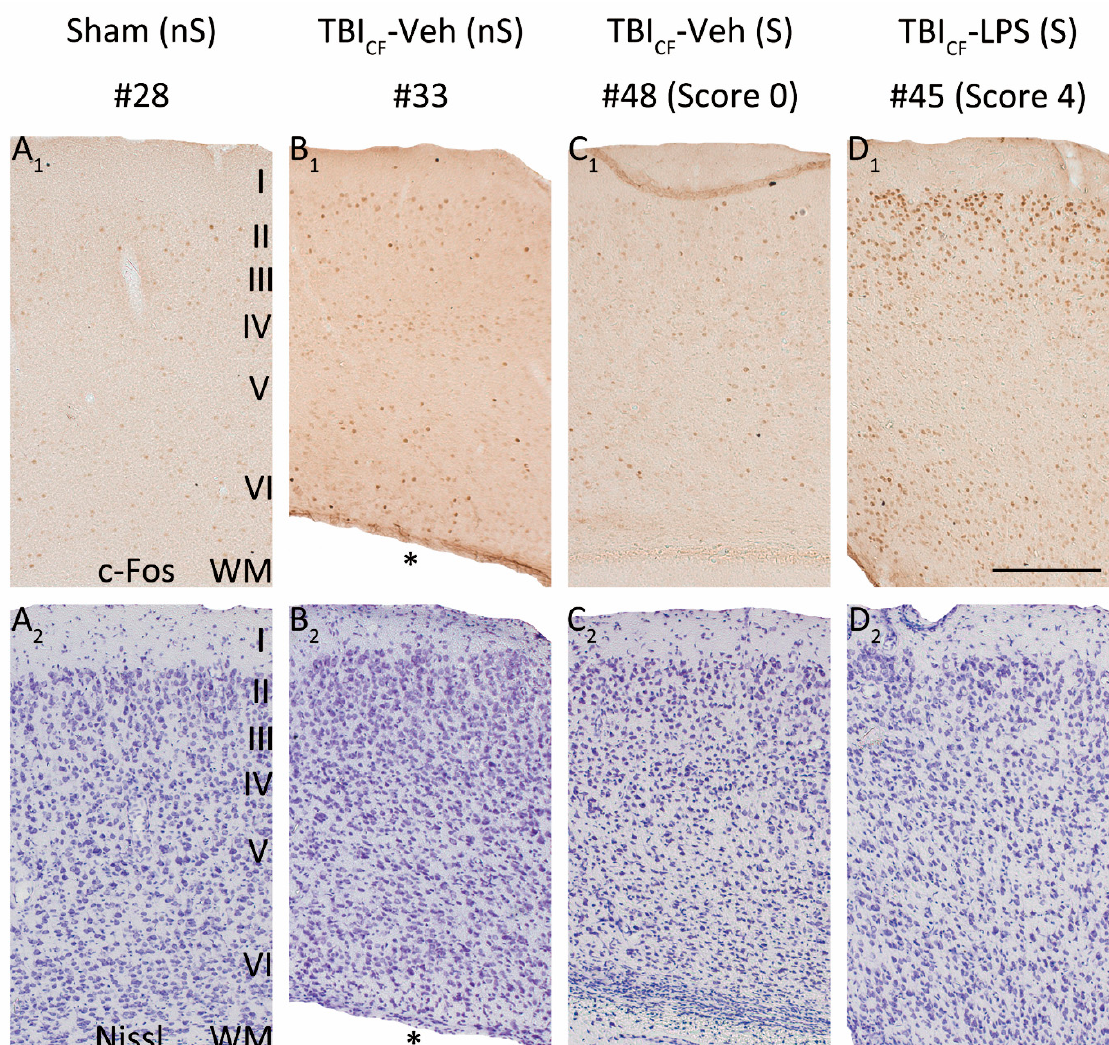
Figure 9. Pattern of c-Fos expression in the caudomedial perilesional cortex. Representative high magnification photomicro- graphs showing c-Fos immunochemistry ( A 1 – D 1 ) and Nissl staining ( A 2 – D 2 ) in the caudomedial perilesional cortex in rats from Sham-Veh group and TBI CF endophenotype at 2 h after PTZ injection (23 weeks post-FPI and 15 weeks after LPS injection). ( A 1 , A 2 ) Example of a rat from the Sham-Veh group without a PTZ-induced seizure (#28). ( B 1 , B 2 ) Example of a rat from the TBI CF -Veh group without a PTZ-induced seizure (#33). ( C 1 , C 2 ) Example of a rat from the TBI CF -Veh group with a PTZ-induced seizure (#48, seizure Racine score 0, only electroencephalographic seizure). ( D 1 , D 2 ) Example of a rat from the TBI CF -LPS group with a PTZ-induced seizure (#45, seizure Racine score 4). Note that in rats without a PTZ-induced seizure, TBI increased PTZ-induced c-Fos expression (( B 1 ) vs. ( A 1 )). In the TBI CF -Veh group, no difference was detected between rats with a PTZ-induced seizure ( C 1 ) and those without a seizure ( B 1 ). In the TBI CF endophenotype with a PTZ-induced seizure, LPS treatment at a chronic time-point after TBI further enhanced c-Fos expression ( D 1 ) compared with vehicle treatment ( C 1 ) in all layers. Abbreviations: CF, cavity-forming; FPI, fluid-percussion injury; LPS, lipopolysaccharide; nS, no seizure; PTZ, pentylenetetrazole; S, seizure; TBI, traumatic brain injury; Veh, vehicle; WM, white matter. Scale bars = 200 µ m. * Enlarged ipsilateral lateral